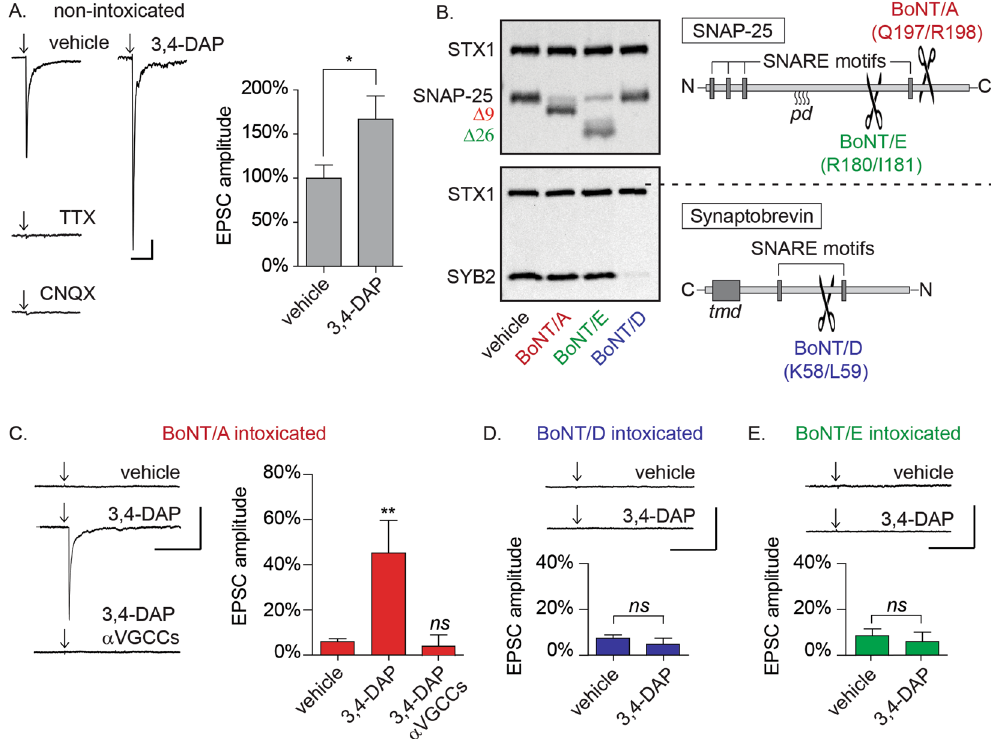
Figure 1. 3,4-DAP restores evoked synaptic release in neuronal cultures intoxicated by BoNT/A but not BoNT/D or BoNT/E. ( A ) Representative whole-cell recordings of evoked neurotransmission in the presence of vehicle, TTX (5 µ M), CNQX (20 µ M), or 3,4-DAP (50 µ M) and quantitation of normalized EPSC amplitudes versus vehicle (n = 6 each for TTX and CNQX; n = 16 for 3,4-DAP). ( B ) Representative Western blots of SNAP-25, STX1 and SYB2 from lysates harvested from primary neuron cultures treated with vehicle, BoNT/A, BoNT/D, or BoNT/E treatment and schematic of SNAP-25 and SYB structure with BoNT/A, /D and /E cleavage sites. Each panel representes a complete image from blots stained for STX1 and SNAP-25 (top) or SYB2 (bottom). Note that while proteolytic cleavage fragments of SNAP-25 can be immunologically detected, cleavage of SYB2 results in the rapid degradation of the N-terminal fragment, and therefore loss of reactivity is considered evidence of intoxication 19 . ( C – E ): Representative whole-cell recordings and of evoked neurotransmission and mean EPSC amplitudes in cultures intoxicated by BoNT/A, BoNT/D, or BoNT/E and treated with vehicle (n = 12), 3,4-DAP (50 µ M; n = 12 for BoNT/A and n = 9 for BoNT/D or E) or 3,4-DAP plus VGCC antagonists (n = 8). Mean EPSC amplitudes are normalized to recordings from age-matched, non- intoxicated control cultures. Arrows represent stimulation times. Scale bars represent 400 ms (x-axis) and 100 pA (y-axis). All data presented as mean ± SEM. * Indicates p < 0.05, ** Indicates p < 0.01, ns = not